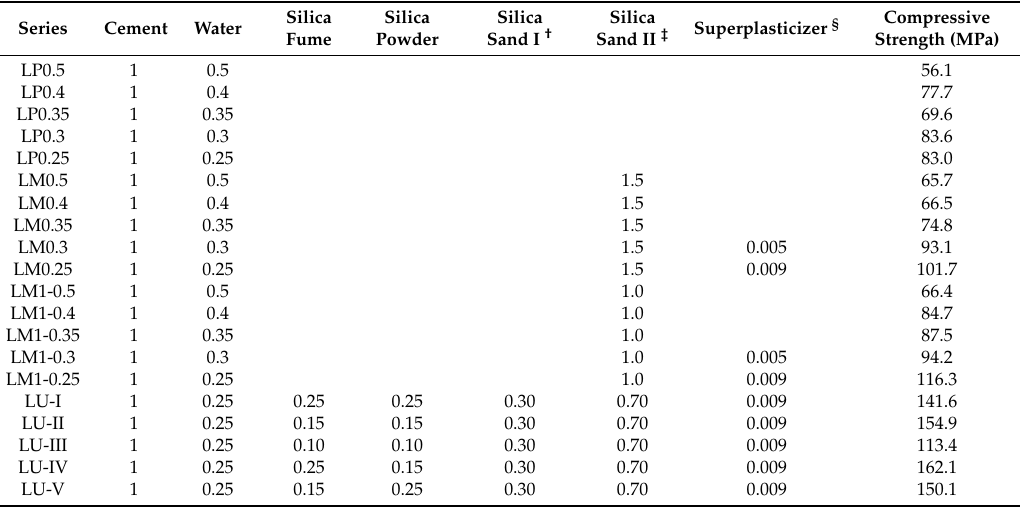
Table 2. Mix design of the tested cement-based materials (proportions by